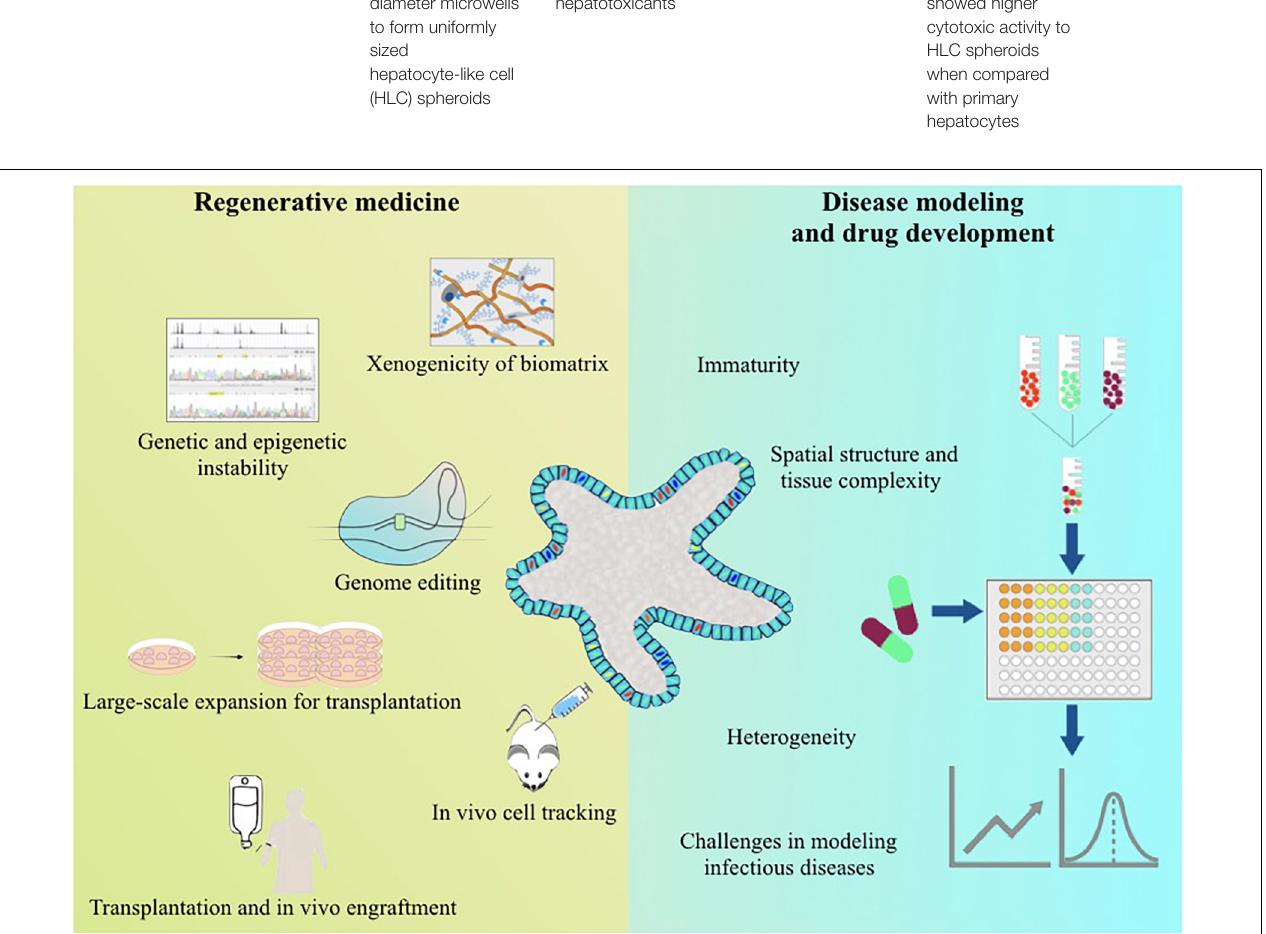
FIGURE 1 | Summary of the current challenges for the applications of human pluripotent stem cell-derived liver organoids.